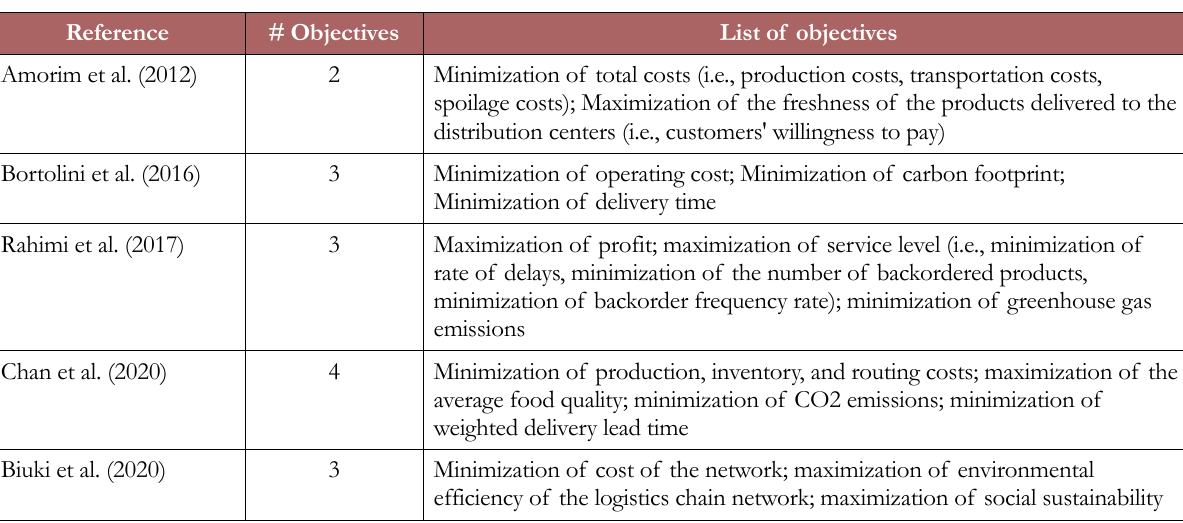
Table 11. Multi-objective